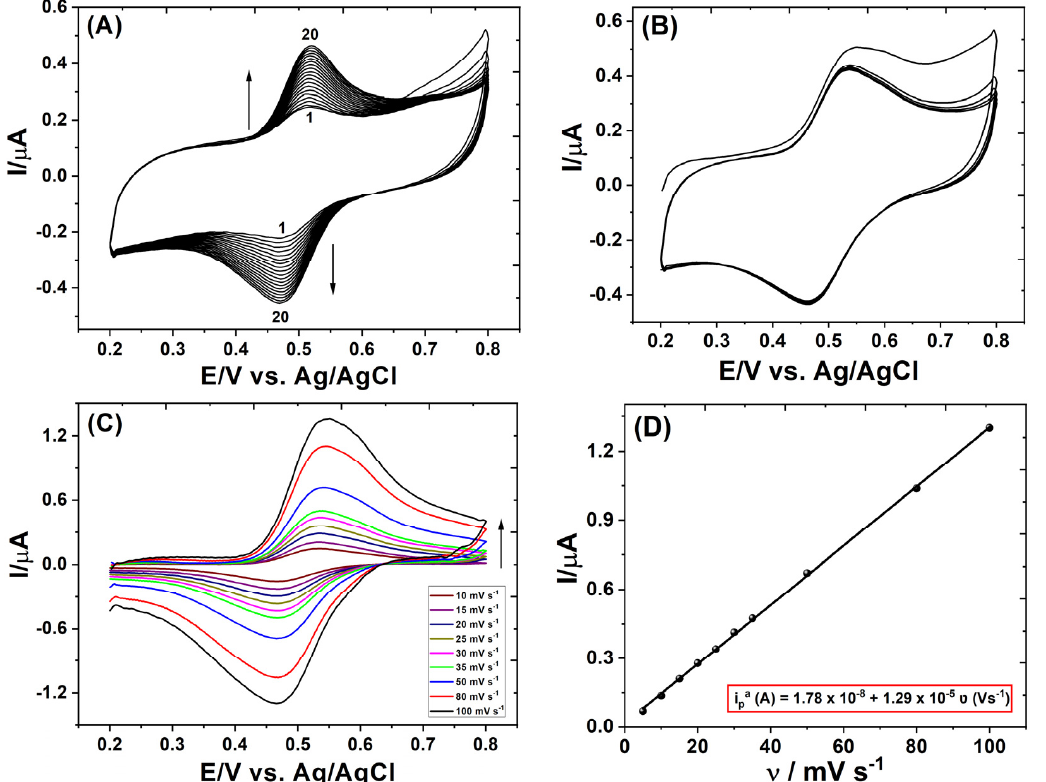
Figure 3. ( A ) CVs of 40 ppm PAs on GCE in B-R buffer (pH 1.80) at scan rate 20 mV s − 1 for 20 cycles. ( B ) Cyclic voltammetry of PAs/GCE in blank B-R buffer a (pH 1.8) at a scan rate of 20 mV s − 1 for 5 cycles. ( C ) CVs PAs/GCE in blank B-R buffer (pH 1.8) at different scan rates (10–100 mV s − 1 ). ( D ) The linear regression plot of the anodic peak current (i p ) vs. scan rate ( ν